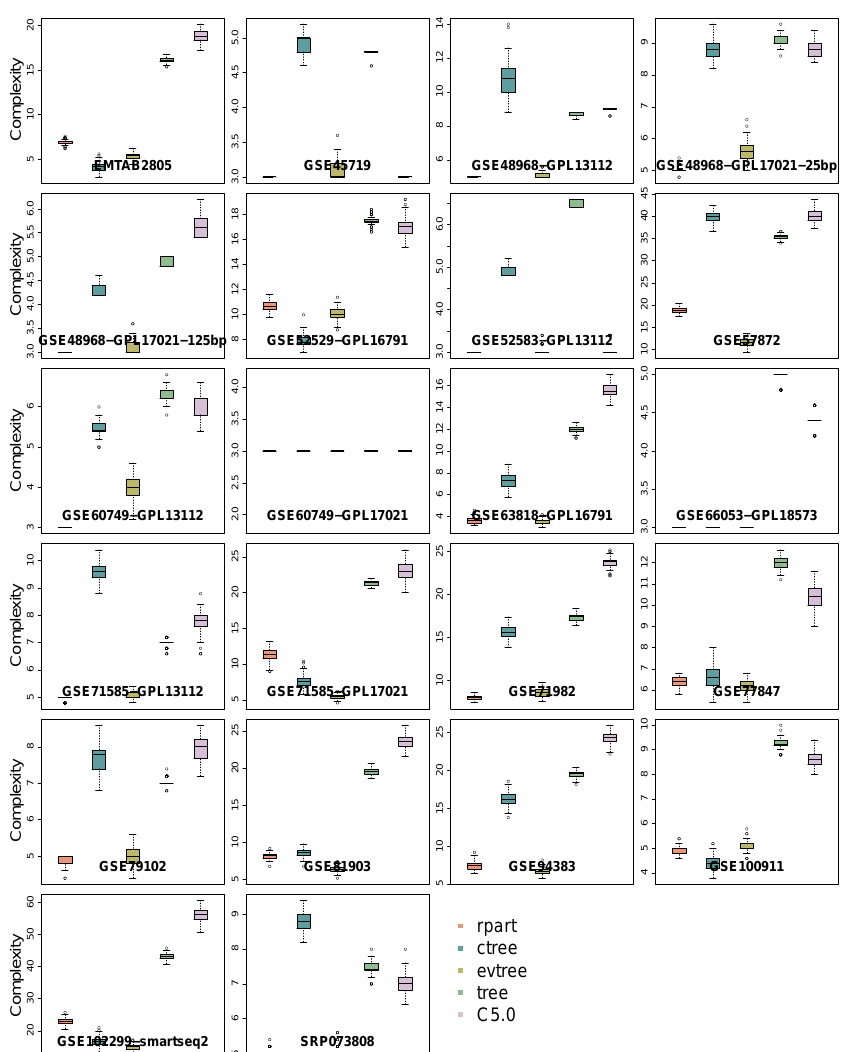
Figure 6. Methods’ Complexity scores on all data sets.